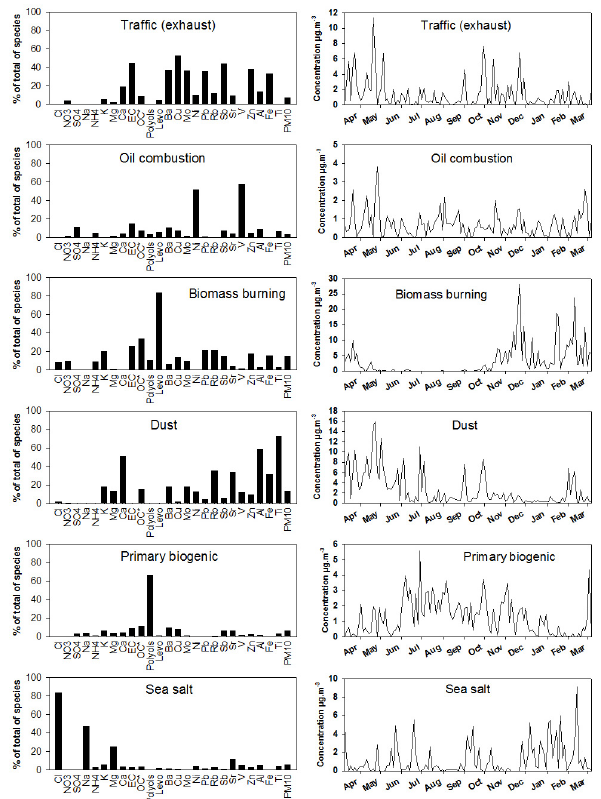
Fig. 5. Source profiles (left panels) and temporal evolutions (right panels) of contributions of primary